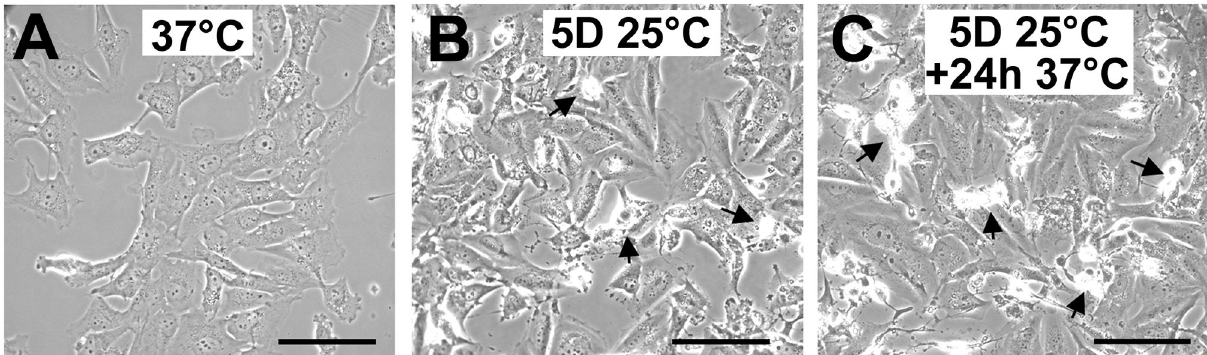
Figure 1. Phase contrast micrographs of WI26 cells. Cells were continuously cultured at 37°C (A), at 25°C for 5 days (B) or at 25°C for 5 days followed by a rewarming to 37°C for 24h (C). Arrows point to refringent, apoptotic-like cells. Bar: 100µm. doi: